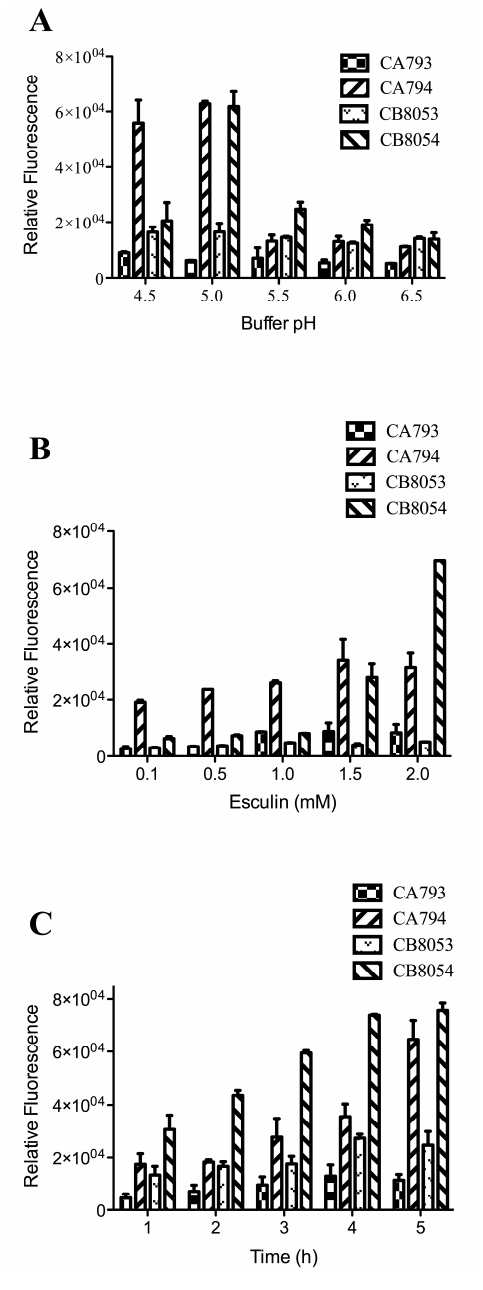
Figure 2. Analysis of esculin uptake in Clostridium strains under different conditions. ( A ) Effect of pH on esculin uptake. Clostridium cells were incubated with 1.0 mM esculin for 2 h at different pH values. ( B ) Effect of the concentration of esculin on esculin uptake. Clostridium cells were incubated with different concentrations of esculin at pH 5.0 for 2 h. ( C ) Effect of incubation time on esculin uptake. Clostridium cells were incubated with 1.0 mM esculin at pH 5.0 for the indicated times. The data represent the mean of three separate experiments ± standard deviation.